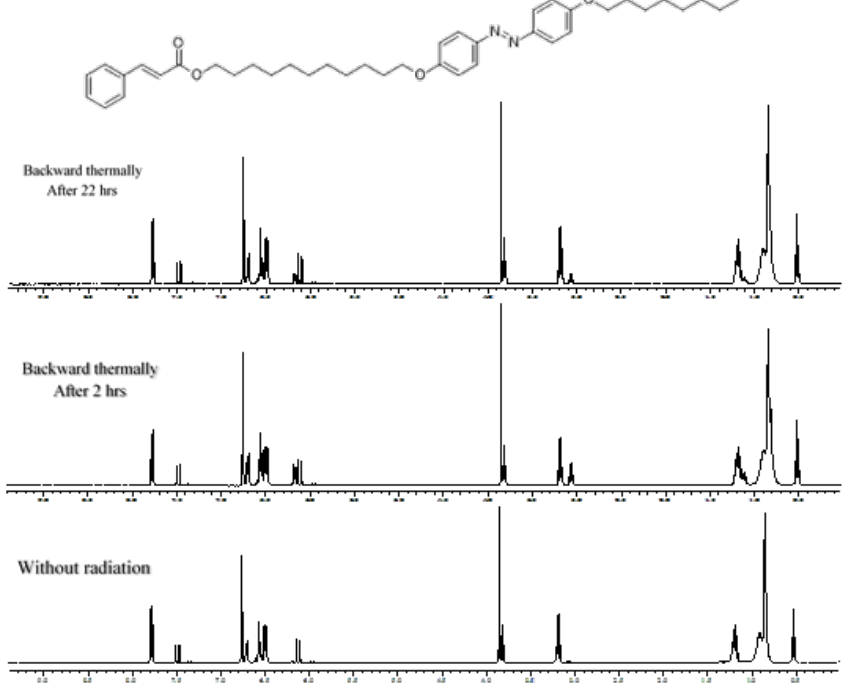
Figure 4. Monitoring by 1 H NMR spectroscopy the thermal cis – trans isomerization of a mixture of cis – / trans – 1c after photoirradiation of trans – 1c . The azobenzene unit isomerizes, while the cinnamate moiety remains trans -configurated during the initial photoisomerization process.